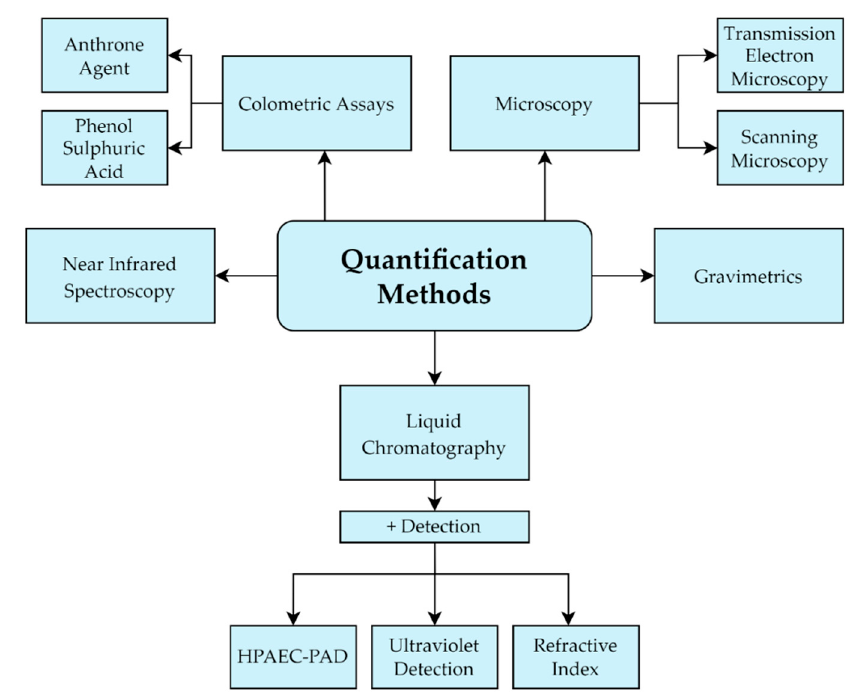
Figure 10. Overview of quantification methods.